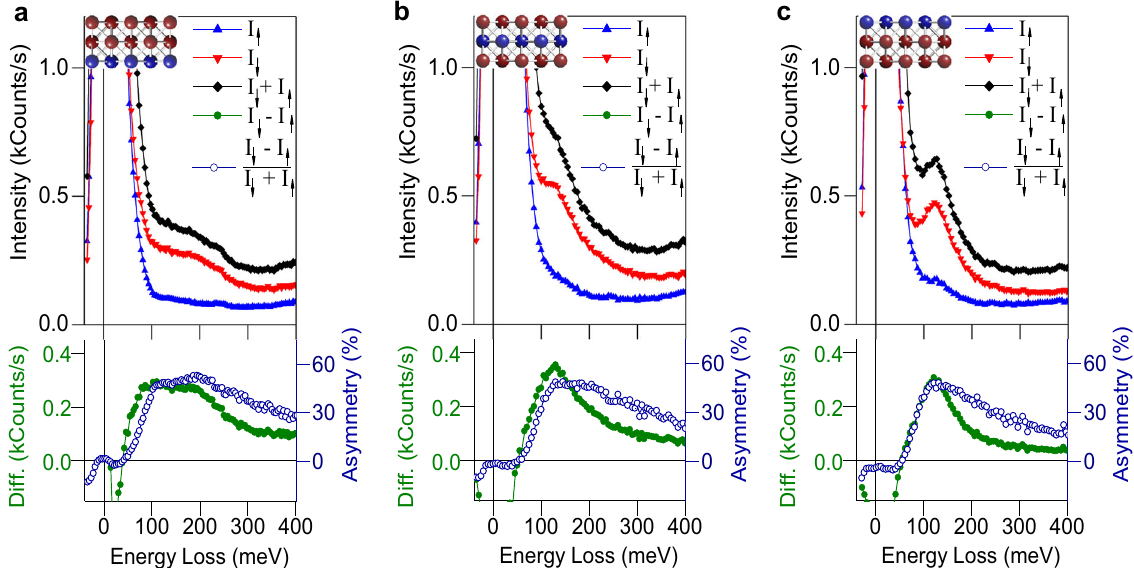
Fig. 1 Spin-polarized high-resolution electron energy-loss spectra recorded on different layered structures. The spectra are recorded at a wavevector of q ∥ = 1 Å − 1 along the (cid:1) Γ – (cid:1) X of a Co/Co/Fe, b Co/Fe/Co, and c Fe/Co/Co, all grown on Ir(001). I ↓ and I ↑ represent the intensity spectra when the spin polarization of the incoming electron beam was parallel and antiparallel to the minority spins of the sample. The sum ( I ↓ + I ↑ ), difference ( I ↓ − I ↑ ), and asymmetry ( I # (cid:2) I " I ) spectra are also shown. In all three examples, several magnon modes are visible in the spectra. The geometrical structures of the # þ I " investigated layered structures are depicted as the insets (blue and red spheres represent Fe and Co atoms,